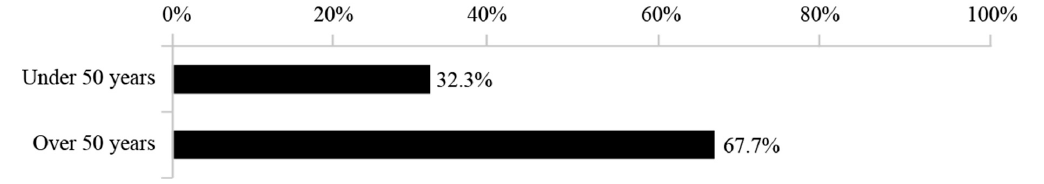
Figure 5. Residence years of targets (n = 31).